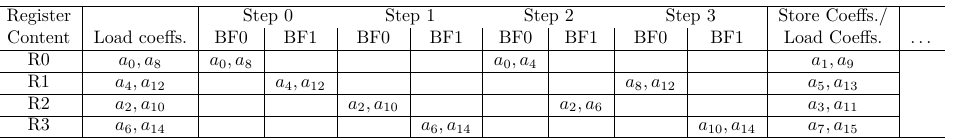
Table 1: Register content and input for the two butterfly units BF0 and BF1 for the example n = 16, l =